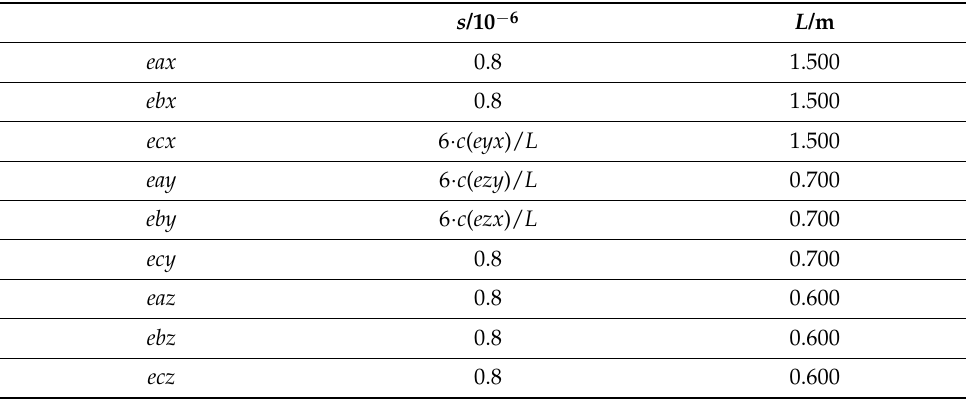
Table 2. Parameters used to simulate the rotational (angular) angular errors of Figure